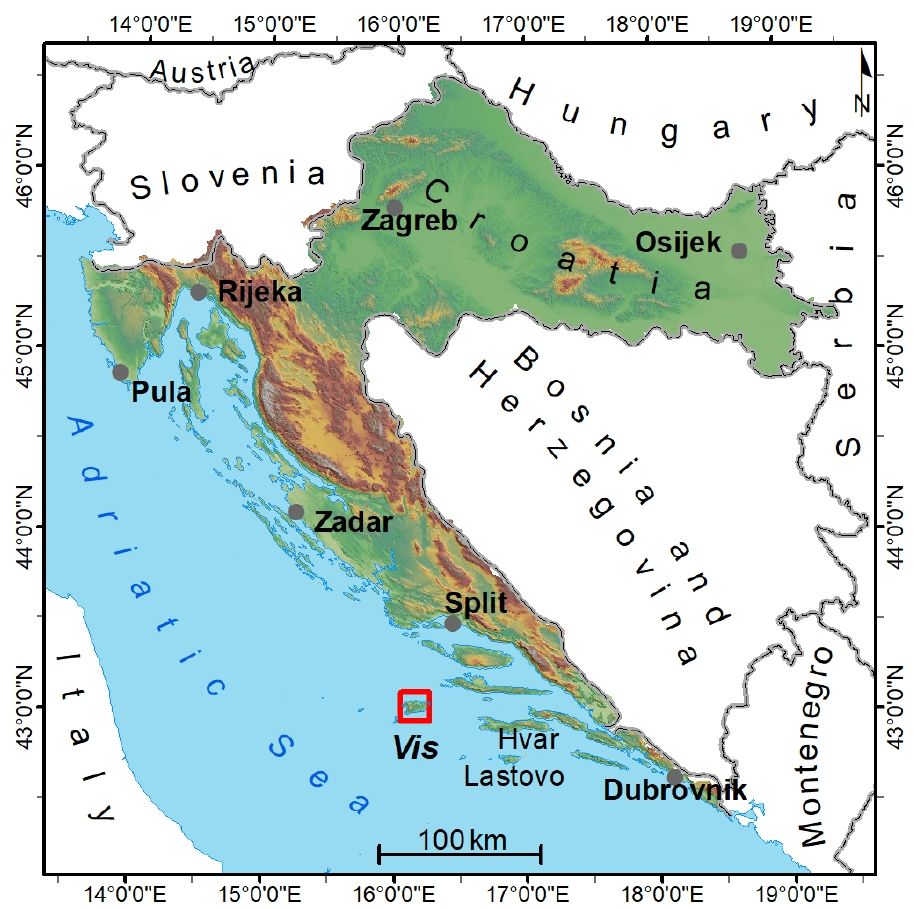
Figure 1. Location of the research area in Croatia and the Adriatic Sea.